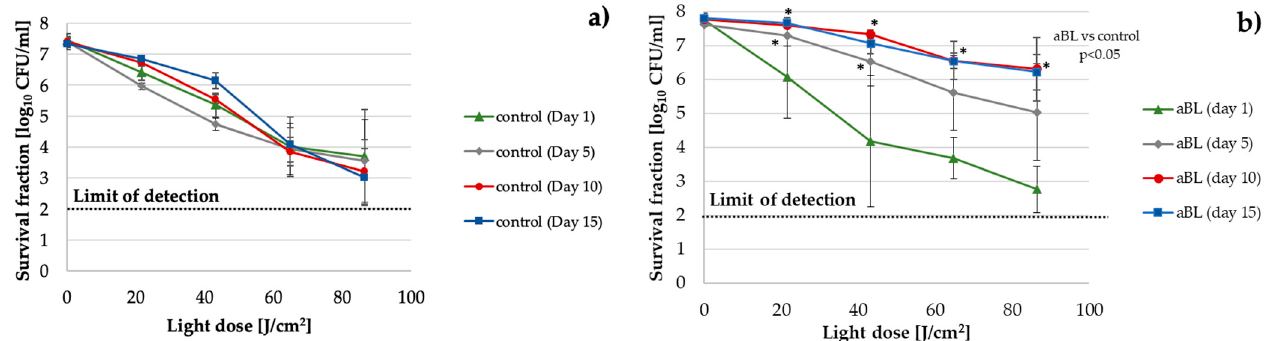
Figure 1. E. coli K-12 aBL tolerance development upon exposure to sublethal aBL treatment. Overnight E. coli K-12 cultures (37 °C in LB for 16–20 h) were diluted to an OD of 0.5 McF, and 100-µL samples were irradiated with 415 nm light at a dose of 32.4 J/cm 2 (MDK 99 ). Following exposure, 10-µL aliquots of the treated samples were collected to determine the survival rate. A total of 50-µL of the sample was transferred into fresh LB medium (5 mL) to regrow overnight. The next day, after 16–20 h of incubation, the treatment was repeated under the same conditions. The cycle of exposure—regrowth—exposure was repeated 15 times. The potential reductions in the susceptibility of E. coli K-12 to aBL were examined after the 5th, 10th, and 15th consecutive cycles at higher doses of light (up to 86.4 J/cm 2 ) ( a ). The efficacy of aBL was also tested in samples from the untreated controls (these were passaged daily without the selective pressure of aBL) ( b ). The detection limit was 100 CFU/mL. The values are the means of three separate experiments. The error bars represent the standard deviations (SDs). * All of the significant differences were estimated in comparison to the control from each day.